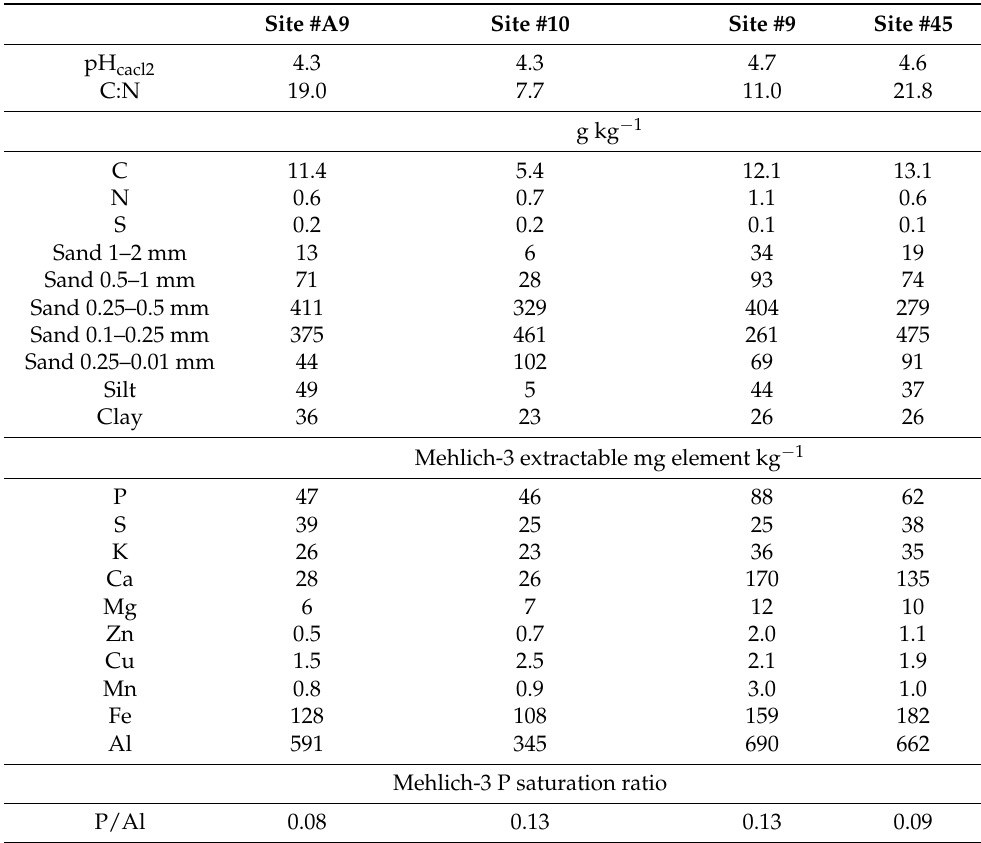
Table 1. Soil chemical properties at experimental sites (0–15 cm